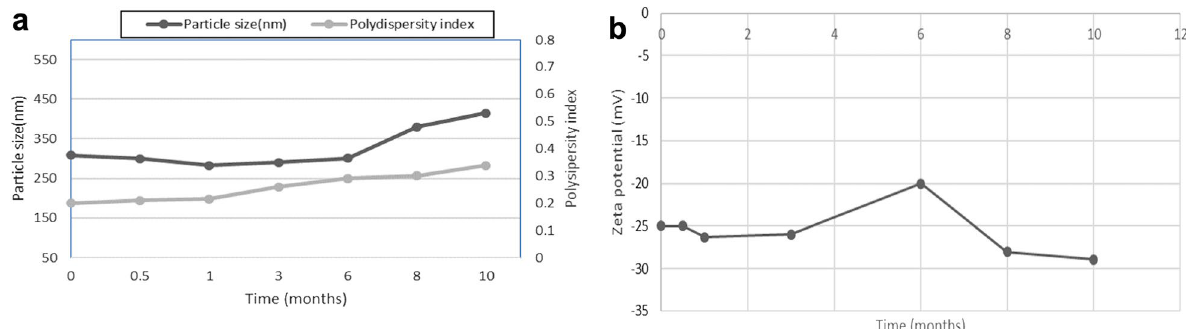
Fig. 8 Stability study of SM-NP-Tw: a the change of particle size and polydispersity index by time, b the change of zeta potential by time